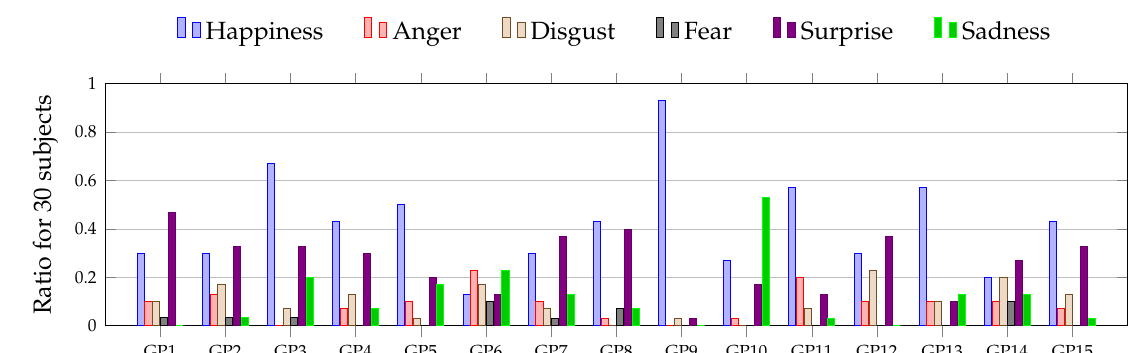
Figure 2. A bar chart representing the frequency of an emotion felt by participants as they watched the 15 gameplay (GP) videos used in this experiment. A representative image from all 15 GP videos are displayed in Figure